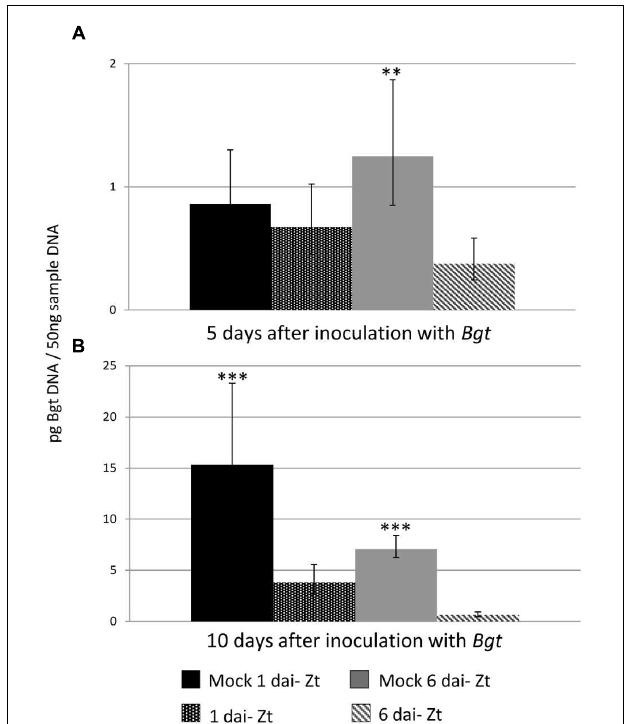
FIGURE 7 | Biomass of B. graminis f.sp. tritici ( Bgt ) on wheat leaves, measured as Bgt DNA as a proportion of total DNA. Leaves of Longbow were pre-inoculated with virulent Z. tritici IPO323 or mock inoculated either 1 or 6 days before inoculation with virulent Bgt isolate JIW48. Samples were taken at 5 (A) and 10 days (B) after mildew inoculation. Bgt DNA (pg per 50 ng sample DNA) was determined by RT-qPCR using a Taqman probe. ∗∗ P < 0.1, ∗∗∗ P < 0.001 based on least significant differences of predicted